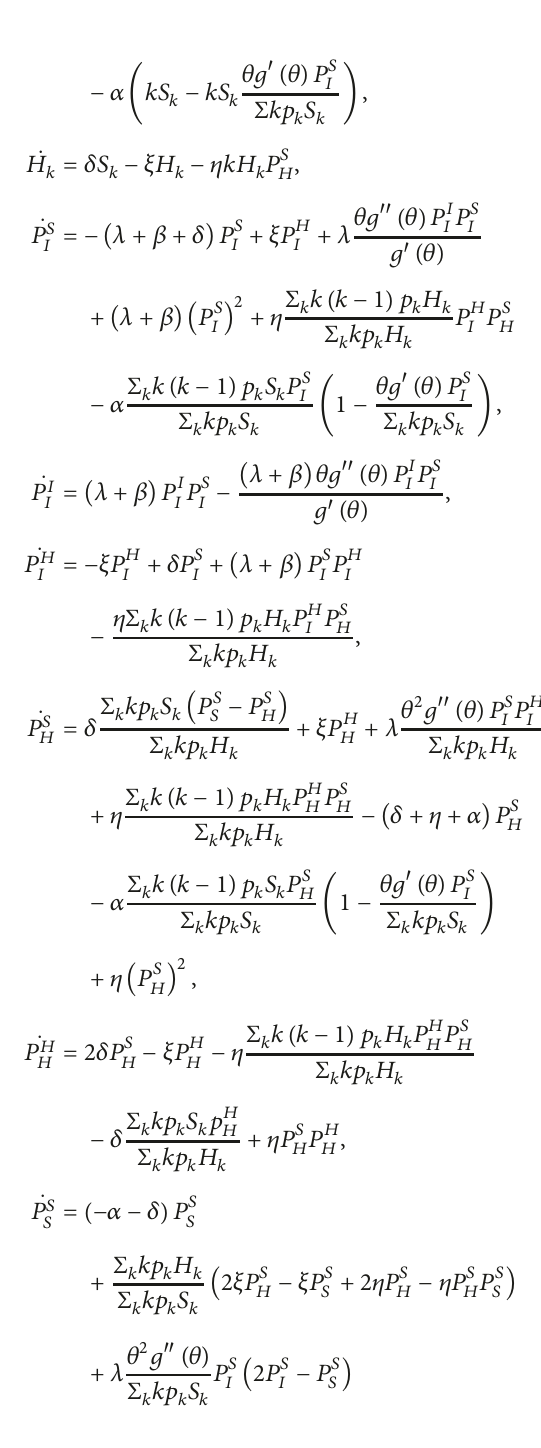
Figure 1: SIHR rumor spreading